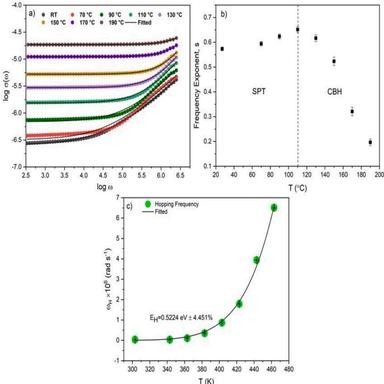
a) the frequency-dependent conductivity of LNMO for RT- 190 ◦C, and variation of b) frequency exponent, s and c) hopping frequency, ωH with temperature ranging from RT to 190 ◦C.